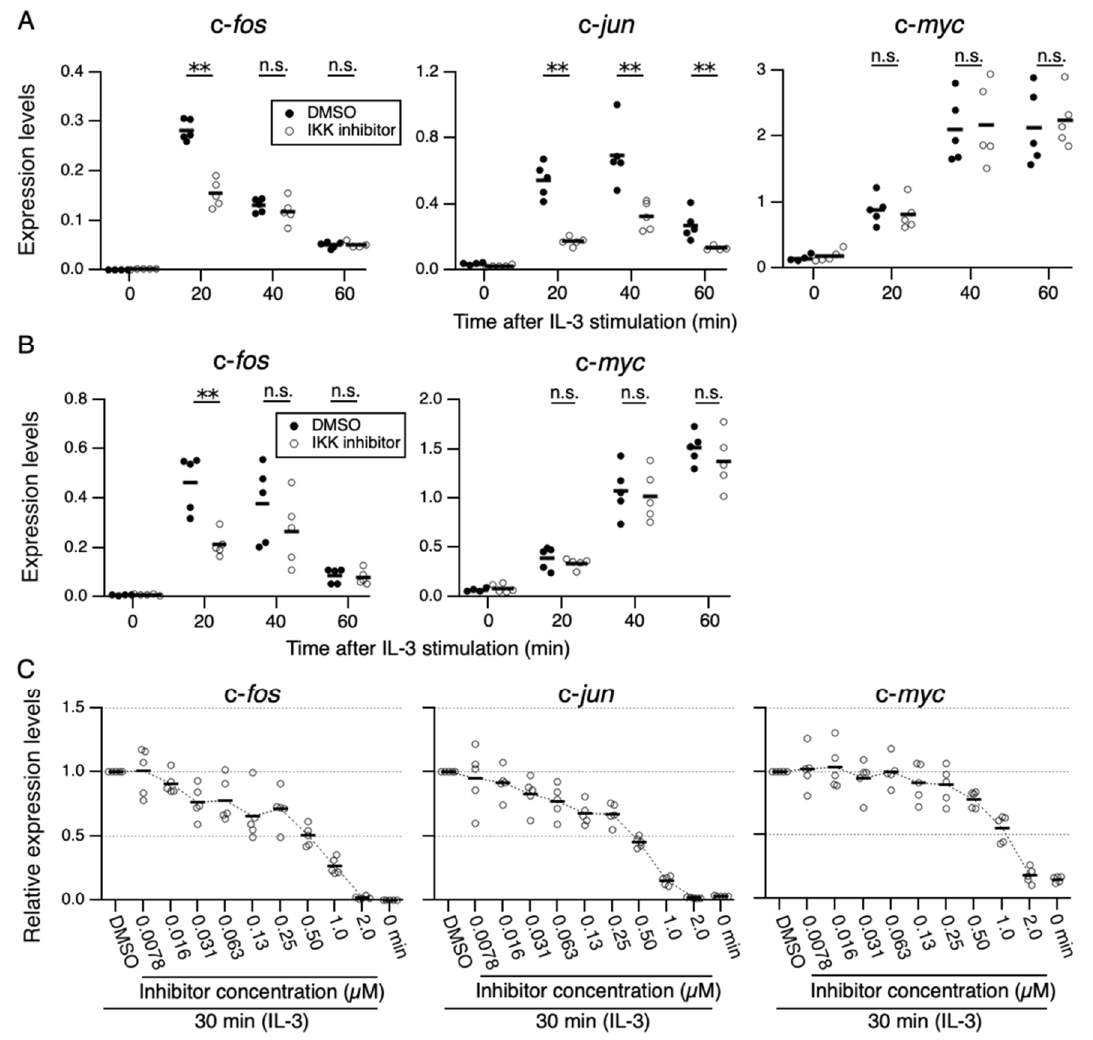
Figure 1. Effects of IKK-16, an IKK inhibitor, on IL-3-induced expression of IEGs. ( A , B ) Levels of expression of c- fos , c- jun , and c- myc mRNAs every 20 min after IL-3 stimulation in Ba/F3 and 32D cells ( n = 5 each). Ba/F3 ( A ) or 32D ( B ) cells were pre-incubated with IKK-16 (0.25 µM) or DMSO for 6 h and then stimulated with IL-3. **, p < 0.01; n.s., not significant, as assessed by Mann–Whitney U -tests, for differences between IKK-16 treated and control cells at each time point. ( C ) Levels of expression of c- fos , c- jun , and c- myc 0 and 30 min after IL-3 stimulation in Ba/F3 cells in the presence of IKK-16 (7.8 nM–2.0 µM) or DMSO. Each dot represents the result from independent experiments ( n = 5 each). Means are indicated by black bars.